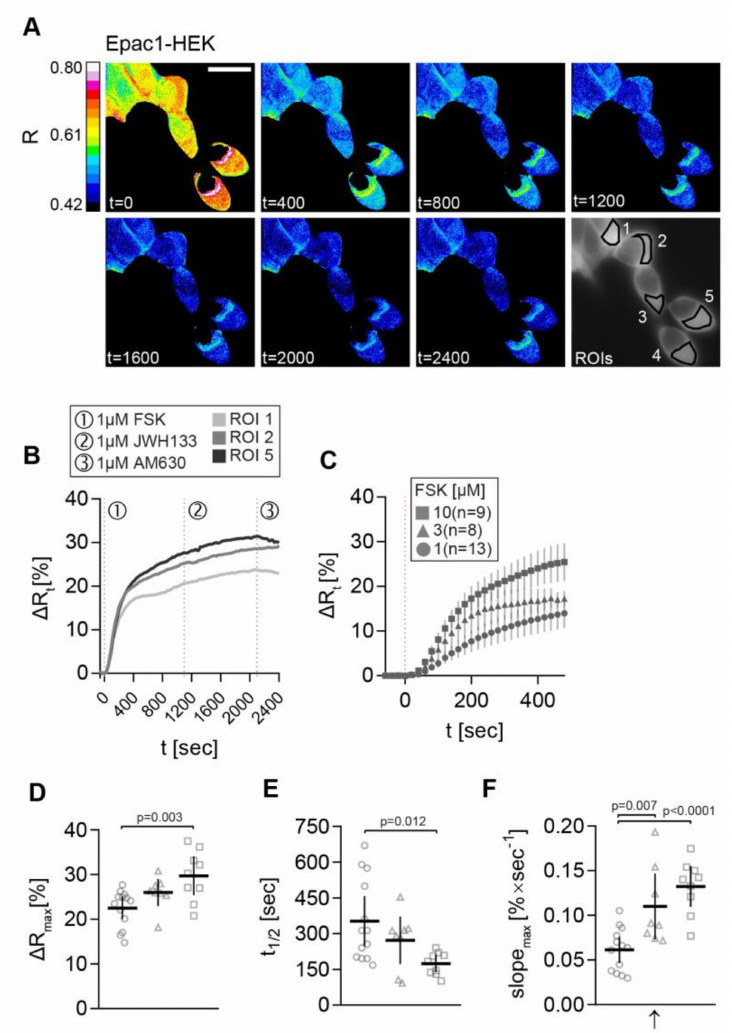
Figure 3. cAMP-FRET imaging of Epac1-HEK cells after stimulation with di ff erent concentrations of FSK. ( A ) Representative FRET ratio (R) images at di ff erent time points (t in seconds) and corresponding single cell FRET ratio ( ∆ Rt) ( B ) traces from indicated Epac1-HEK cells stimulated with 1 µ M FSK (1), 1 µ M CB2 agonist HU308 (2) and 1 µ M AM630 (3). ( C ) Mean ± 95%CI ∆ Rt FRET ratio traces